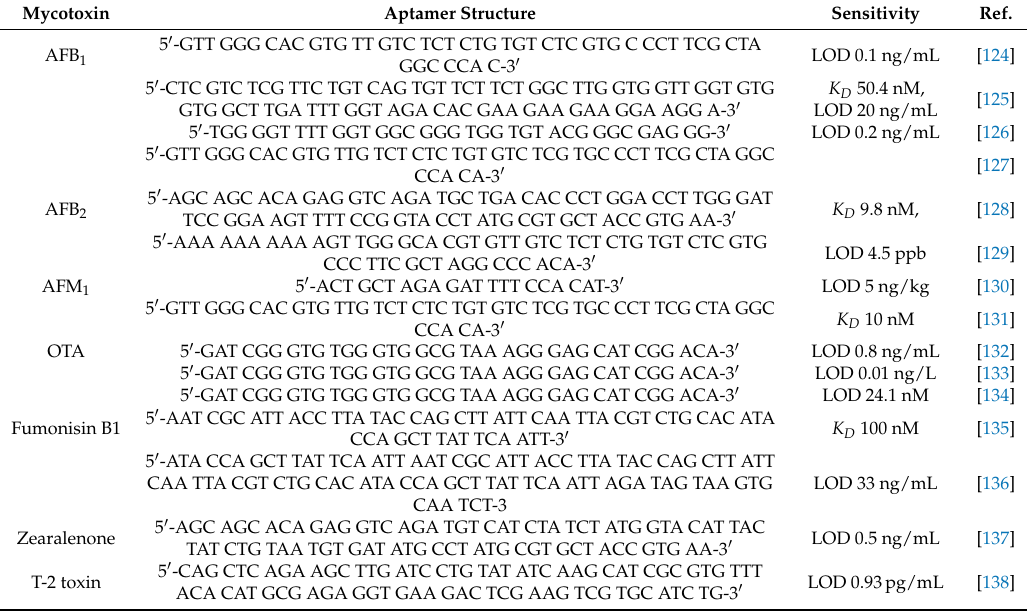
Table 3. Aptamers selected against various mycotoxins for their determination ( K D —dissociation constant of the aptamer-mycotoxin complex, LOD—limit of detection).